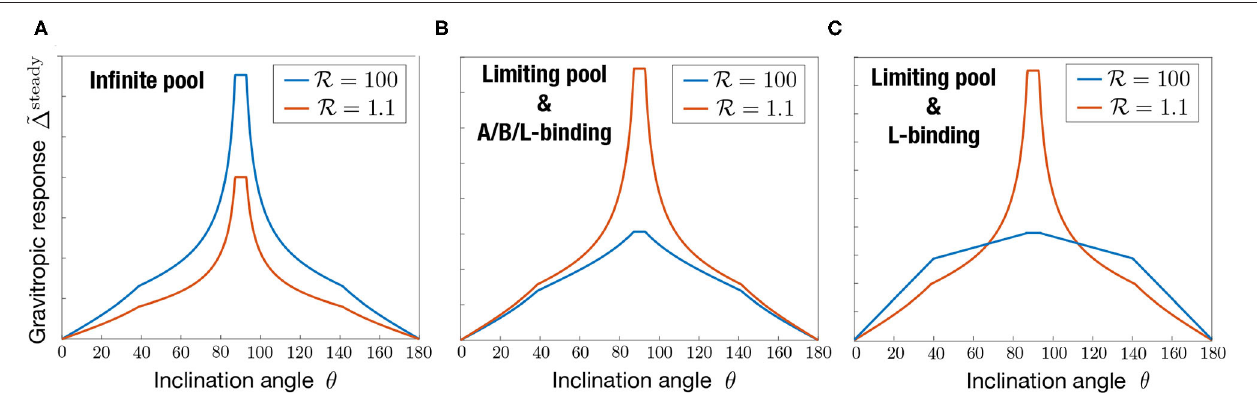
FIGURE 6 | Shape of the steady gravitropic response ˜ 1 steady (arbitrary amplitude) as a function of the inclination angle θ , for the statolith-PIN coupling parameter R either large or close to 1, in the case of (A) infinite pool ( P only. Note that in the case of an infinite pool, results are the same in the A/B/L-binding or L-binding case. Note also that the shape of the response no longer depends on P in both the infinite pool and limiting pool regimes. Geometrical parameters used are H stato